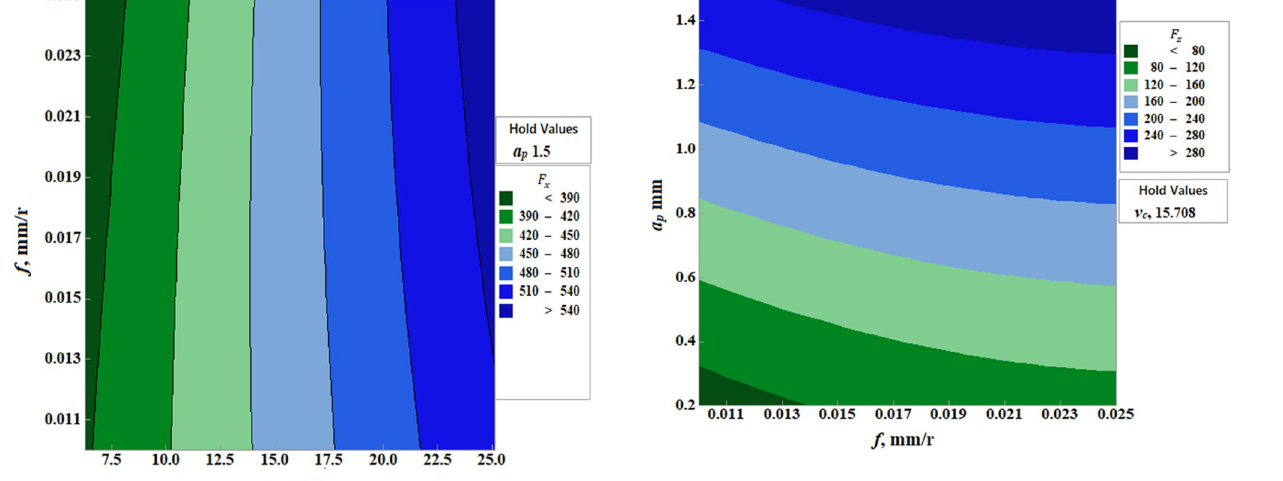
Fig. 7 Cutting force F z vs a